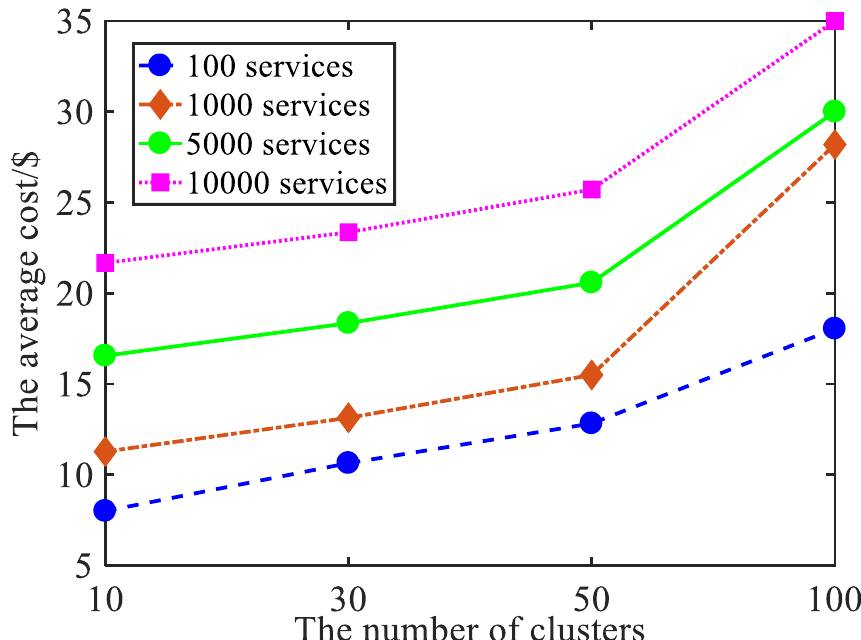
Fig. 9 The average cost of RHGA on